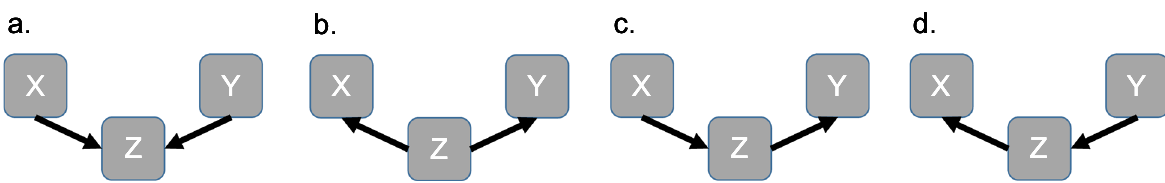
Fig. 3 Discovery of causal orientations using conditional independence relationships. Four different ways that three variables X , Y , and Z could be causally related. a is a structure known as a “ collider, ” in which X and Y both cause Z , but X and Y are not related. In this structure, X and Z are dependent, and Y and Z are dependent, while X and Y are independent. However, when Z is conditioned on (controlled for), X and Y are dependent. Meanwhile, in panel b , Z causes both X and Y . In this structure, X and Y are dependent because of their common cause, and are independent when Z is conditioned on. In panels c, d , X and Y are dependent because one causes Z , which then causes the other. In both of these panels, X and Y are independent when Z is conditioned on, as Z is the only link from X to Y . GFCI utilizes conditional independence tests to determine causal direction in graph edges, speci fi cally by identifying “ collider ” cases in the graph (since these cases imply different conditional dependencies than the other